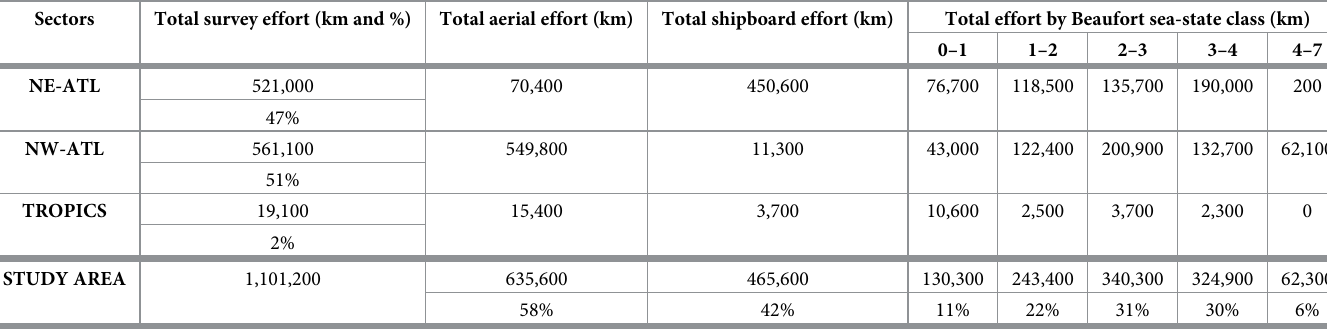
This table presents the total effort conducted in each sector broken down by platform type and Beaufort sea-state. Beaufort sea-state values reported with decimals in the surveys were rounded up. For the analyses, all segments with Beaufort sea-state > 4 were excluded. ‘NE-ATL’ means northeast Atlantic Ocean and ‘NW-ATL’ means northwest Atlantic